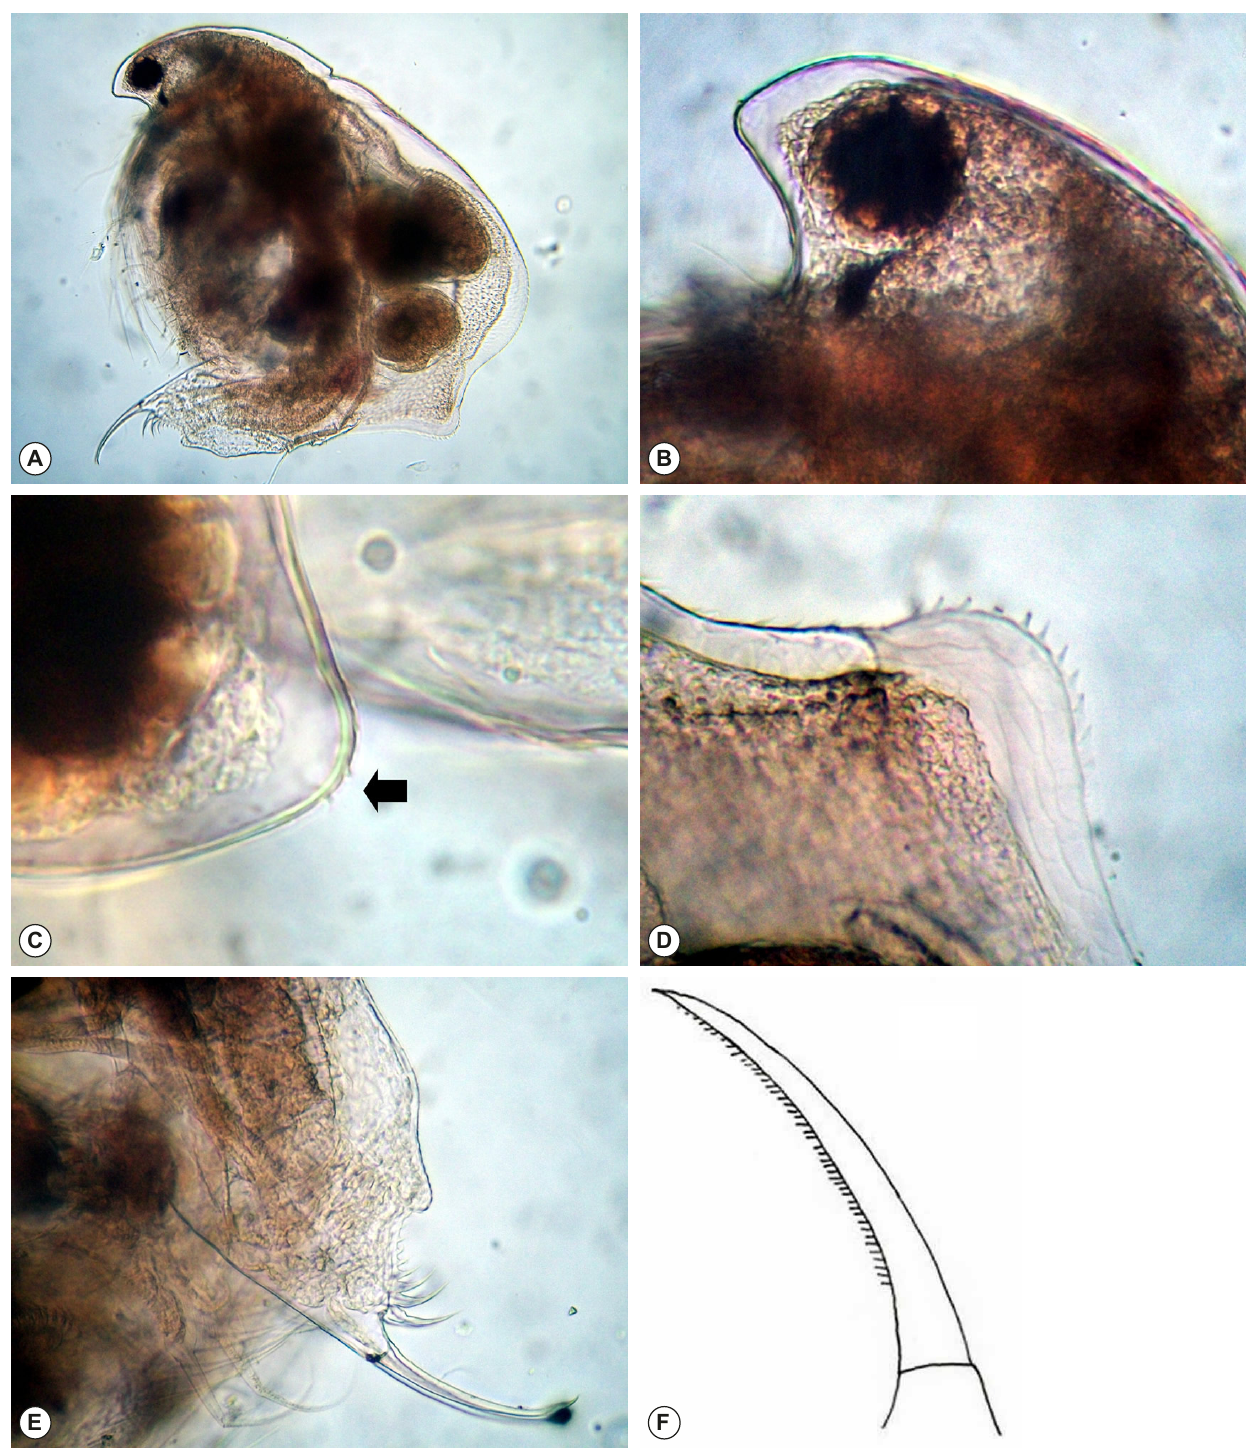
Figure 2. Simocephalus serrulatus . A. Adult. B. Ocellus. C. Frontal part of head with denticles (arrow points at denticles). D. Dorso-posterior valve E. Postabdomen. F. Postabdominal Claw (outer